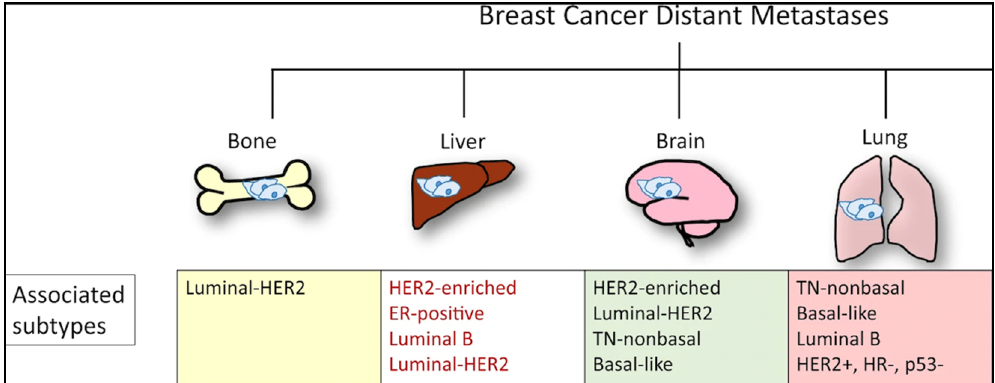
Figure 2. Molecular subtypes of BC and sites of the most commonly reported metastases. From Chen W, Hoffman AD, Liu H, Liu X. Organotropism: new insights into molecular mechanisms of breast cancer metastasis. NPJ Precis. Oncol. 2018;2, 4. DOI: 10.1038/s41698-018-0047-0 [28]. http://creativecommons.org/licenses/by/4.0/, accessed on 2 May 2022.